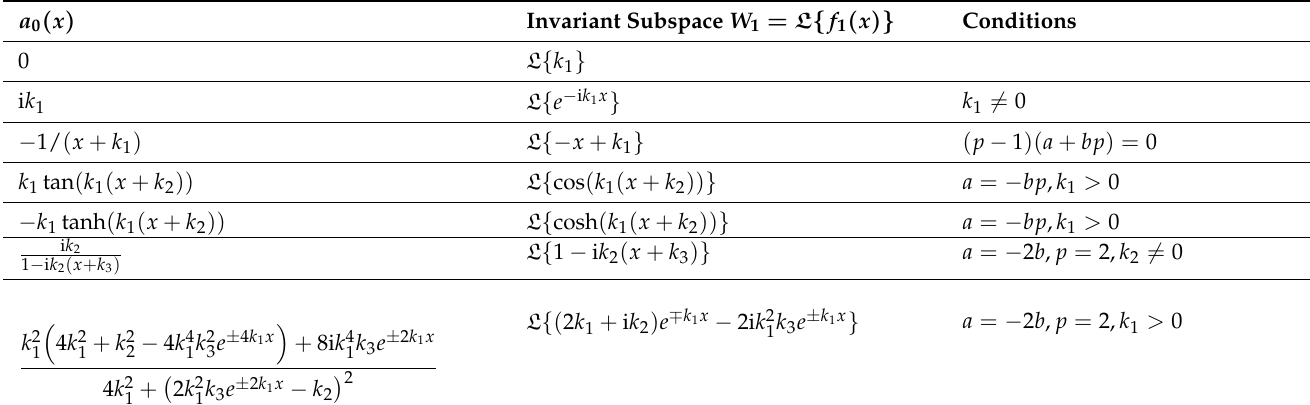
Table 3. One-dimensional invariant subspaces W 1 of (38).